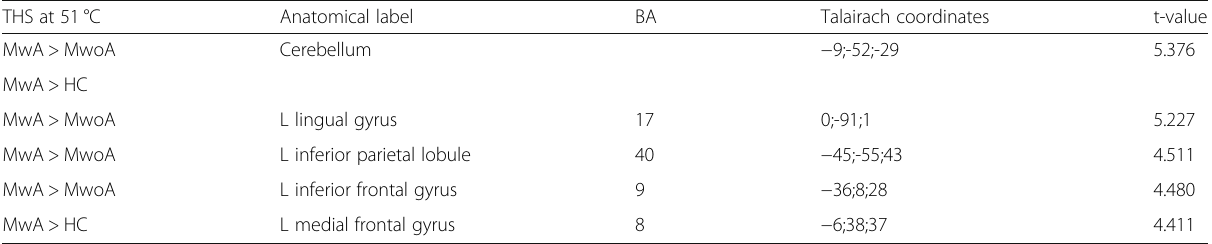
Table 2 Significant cluster differences between patients with MwA, patients with MwoA and HC ( p < 0.001 cluster level corrected) THS at 51 °C Anatomical label BA Talairach coordinates